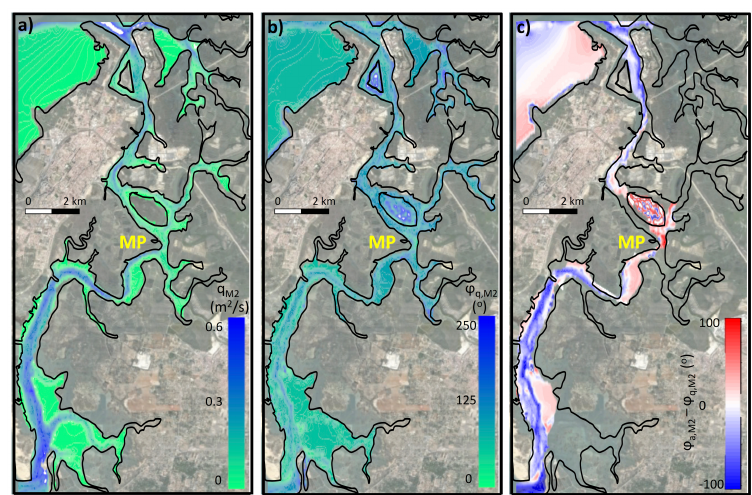
Figure 8. Results of the tidal-current harmonic analysis for the M2 component. The magnitude of q M 2 (m 2 /s) and the phase of q M 2 ( ◦ ) are labeled in the panels ( a , b ), respectively. Panel ( c ) corresponds to the difference between the phase associated with the velocities and the water levels for M2 ( ◦ ).